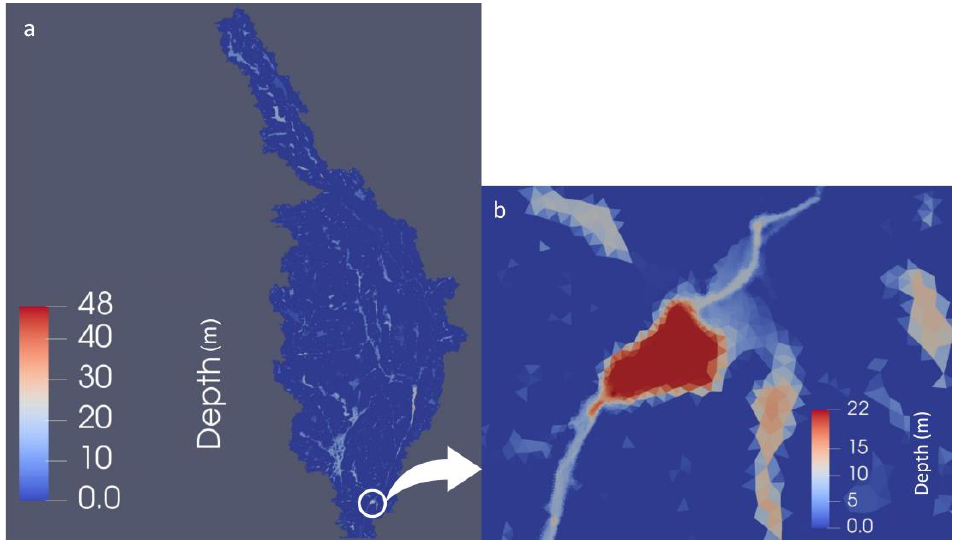
Figure 2. Water depth ranges in the calibrated model: ( a ) computational domain, ( b ) case study region.